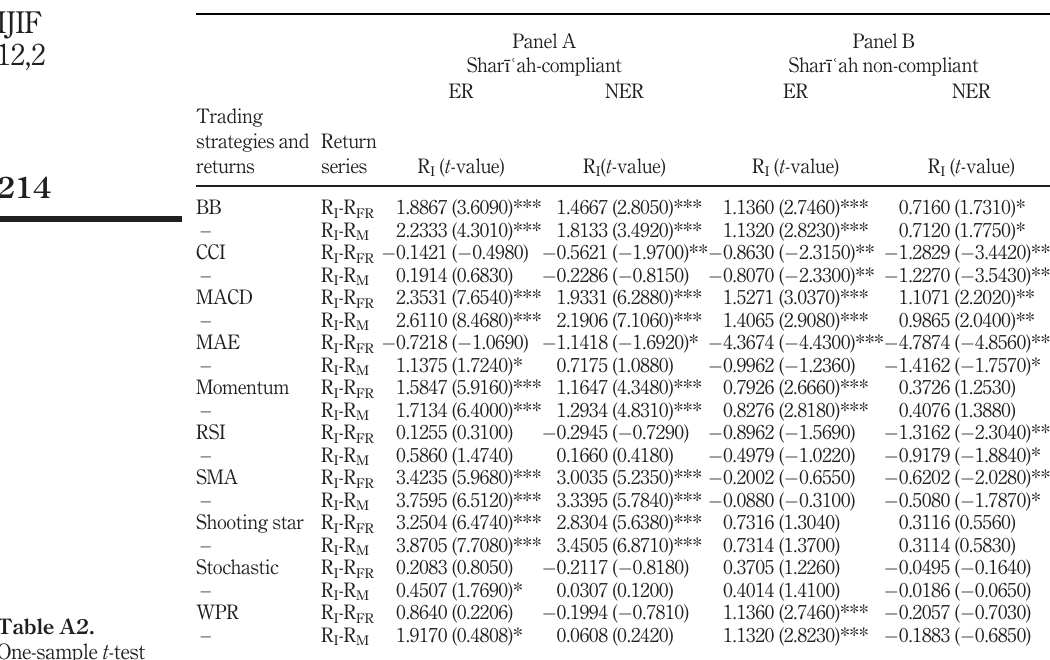
Table A2. One-sample t -test